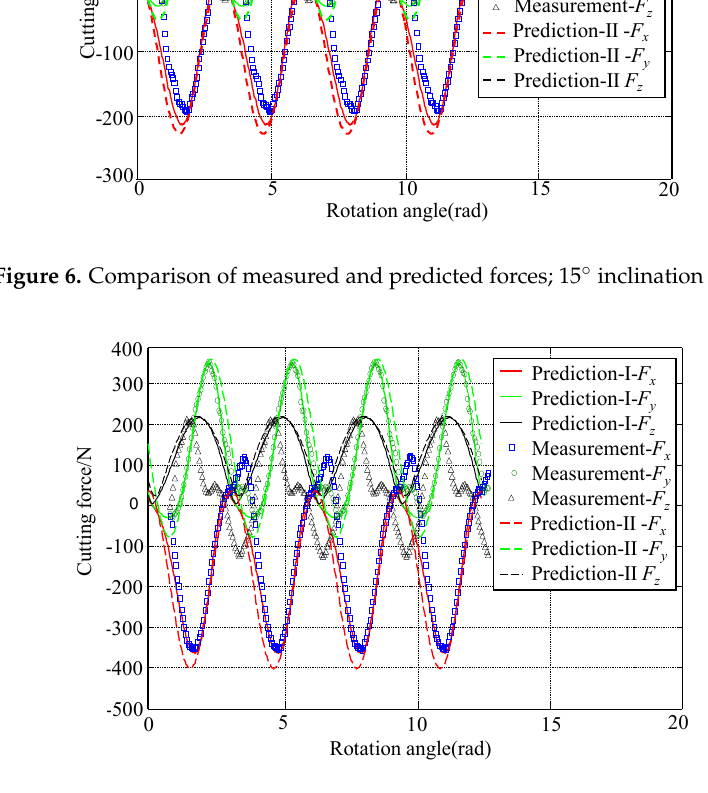
Figure 7. Comparison of measured and predicted forces, 25° inclination angle.